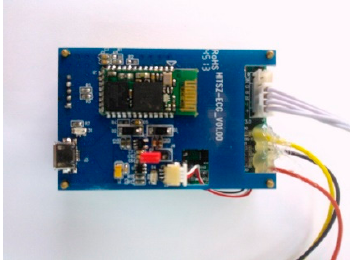
Figure 3. ECG and blood oxygen collection equipment.